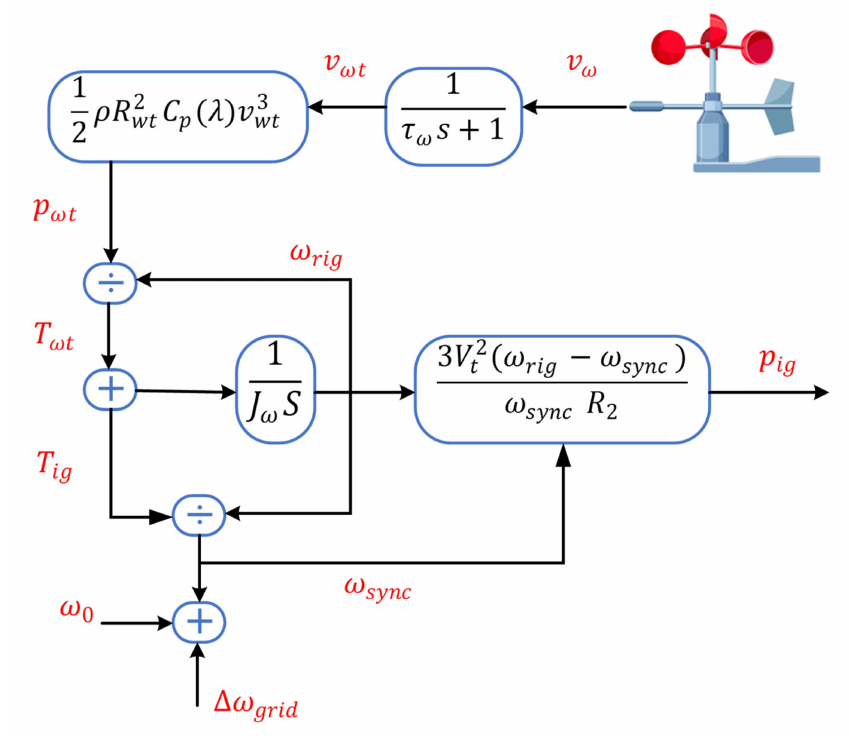
Figure 4. Wind turbine model